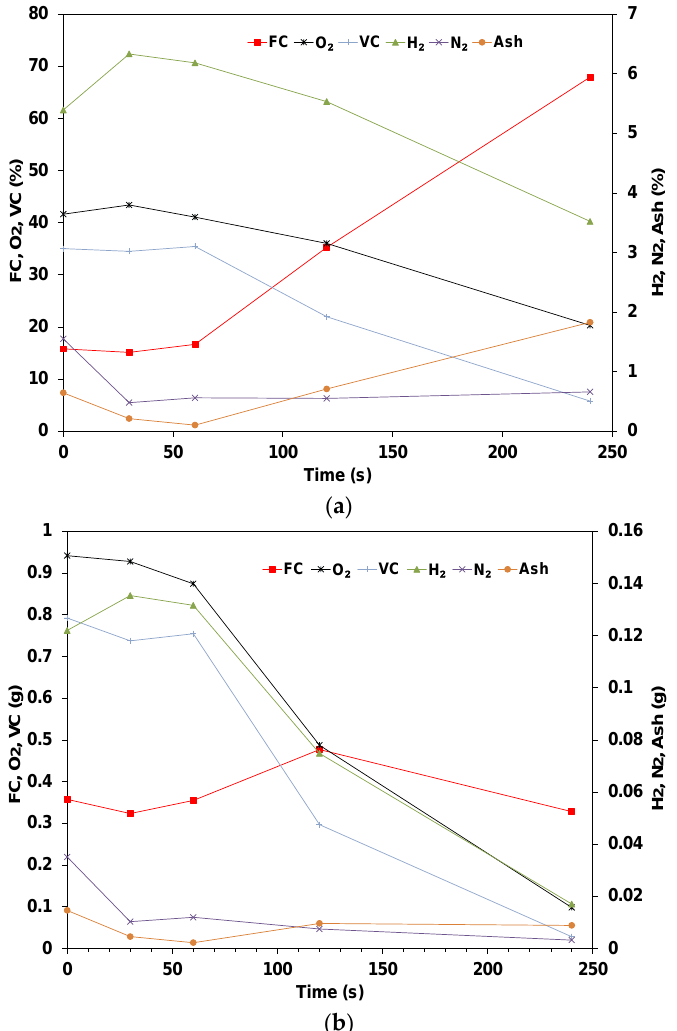
Figure 8. Elemental analysis of wood pellets at 541 ◦ C: ( a ) in percentages and ( b ) in